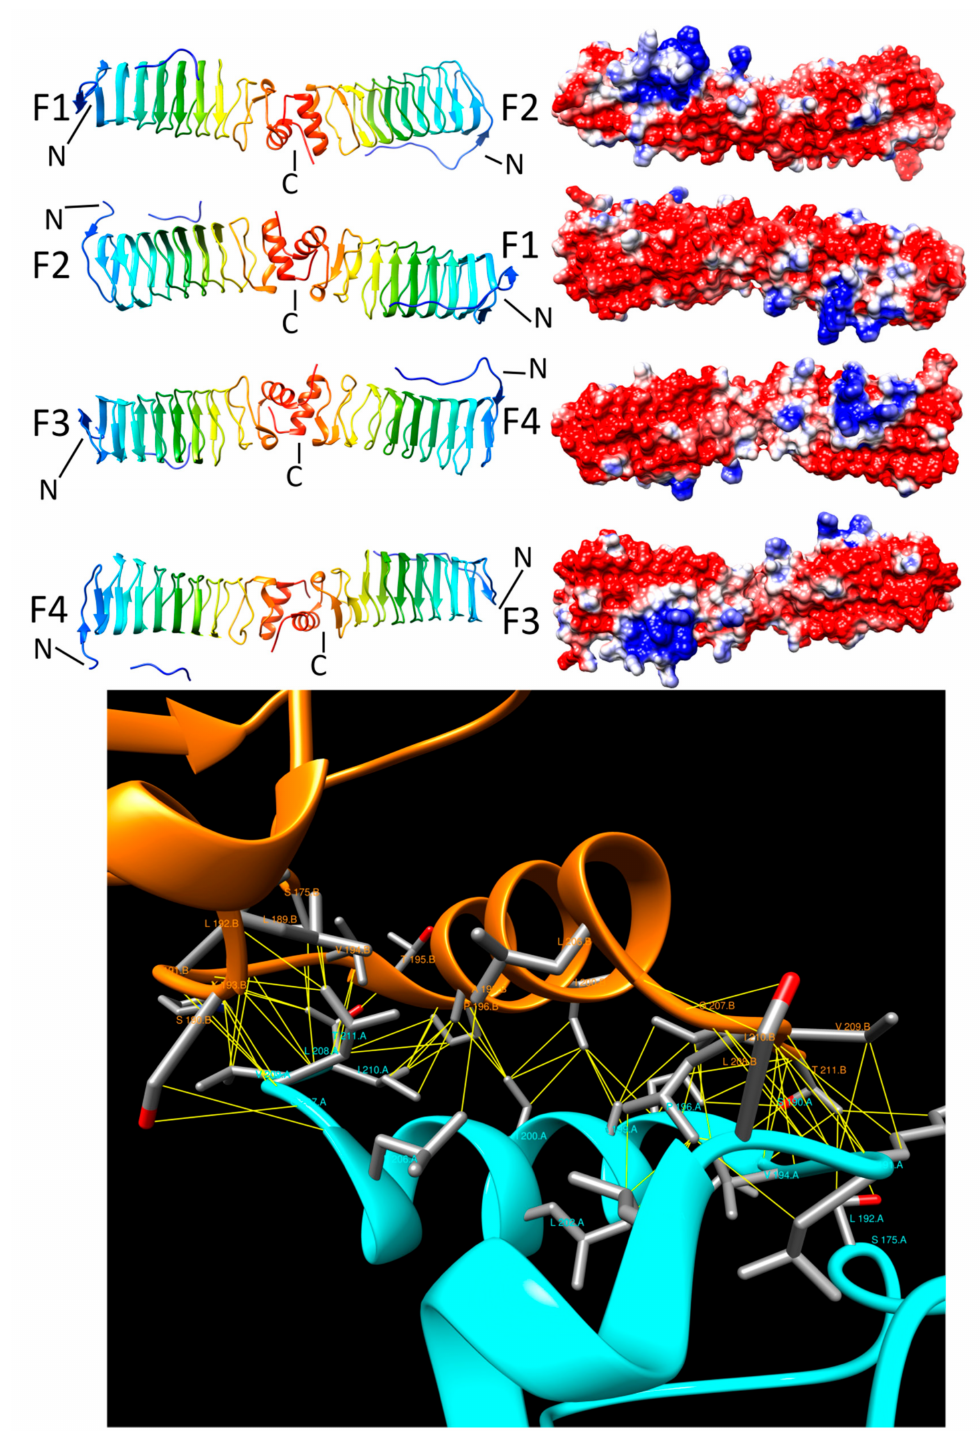
Figure 5. Structure and analysis of EfsQnr. The top panel shows the ribbon diagrams of the structure for four different orientations (at left) and the corresponding electronic potential surface plots (at right). The bottom panel is the interface model calculated by Intersurf and depicted using